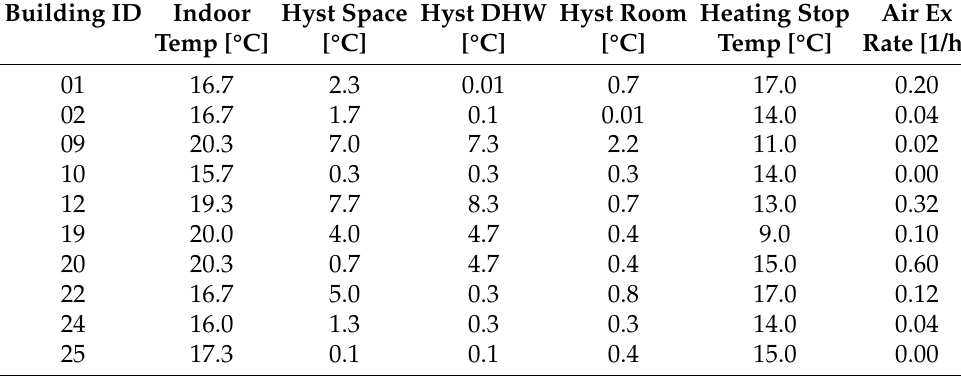
Table 7. Model parameter after